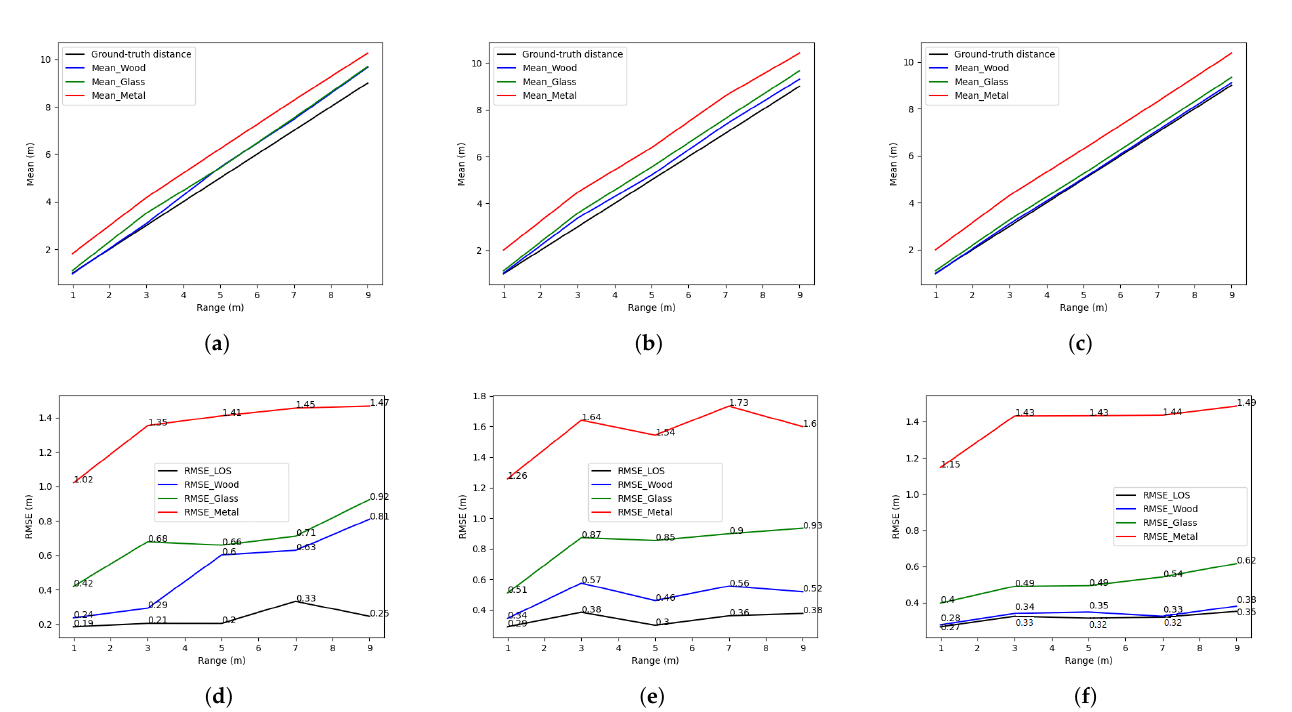
Figure 11. Wi-Fi RTT distance and error in RFPV and NLOS condition: ( a ) Wi-Fi RTT distance from Google Pixel 2; ( b ) Wi-Fi RTT distance from Xiaomi Redmi K20; ( c ) Wi-Fi RTT distance from LG V50S; ( d ) RMSE of Wi-Fi RTT distance from Google Pixel 2; ( e ) RMSE of Wi-Fi RTT distance from Xiaomi Redmi K20; ( f ) RMSE of Wi-Fi RTT distance from LG